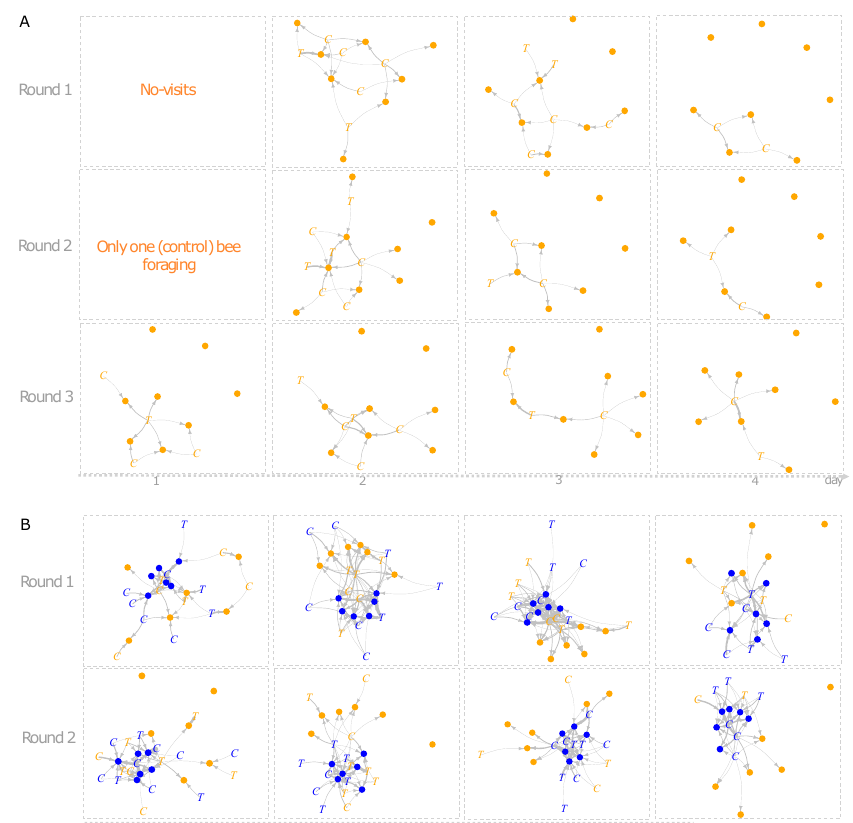
Figure 2. Network interactions of O. bicornis on artificial flowers in environment type 1 ( A ) and environment type 2 ( B ). Bees are indicated by “C” and “T” (control and treated with fenbuconazole, respectively) and the colour of the letter indicates the training phase (blue or yellow flower) of a given individual. Coloured dots indicate flowers in both experiments and thickness of links indicates the number of interactions.